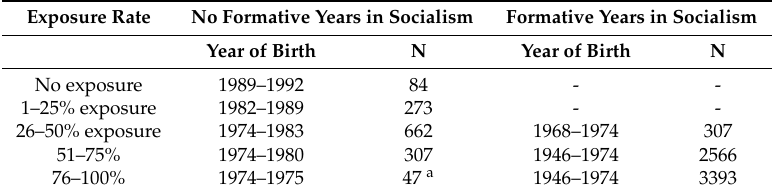
Table A3. Overview of Birth cohorts by Socialization for Post-socialist